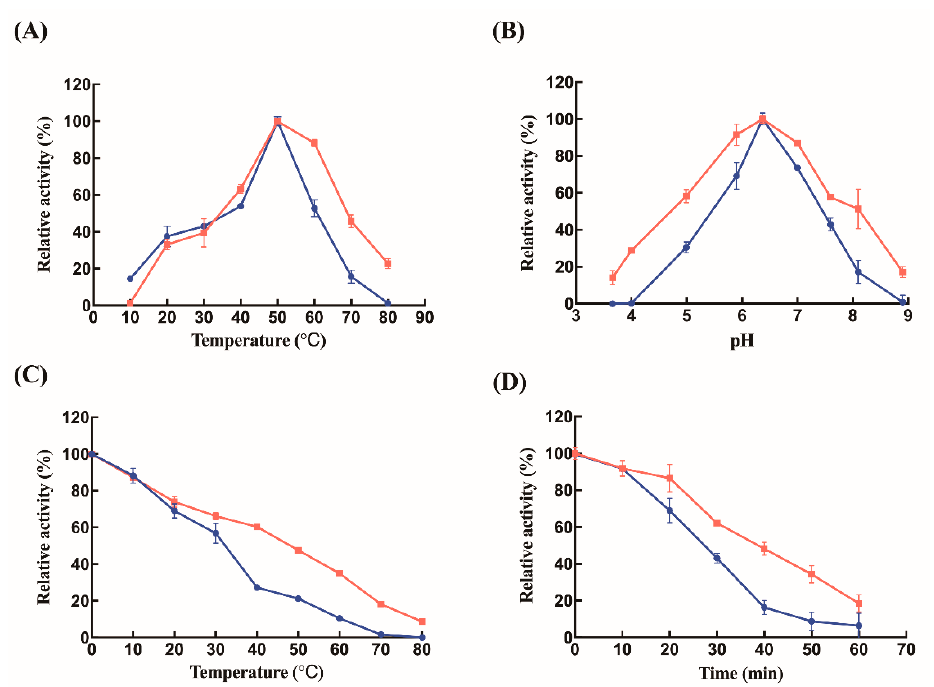
Figure 3. Biochemical characterization of free (blue circles) and immobilized (red squares) lysozyme. ( A ) Optimal temperature of the free lysozyme and immobilized lysozyme. The activities were determined in 20 mM sodium phosphate buffer (pH 6.5) for different temperatures from 10 to 80 °C. ( B ) The effect of pH on the activities of free lysozyme and immobilized lysozyme. Enzymatic activity assay was processed at 50 °C in various buffers as follows: 20 mM sodium acetate buffer (pH 3.7–5.0), 20 mM phosphate buffer (pH 6.0–7.0), and 20 mM glycine-NaOH buffer (pH 7.6–8.9). ( C ) Thermal stability of free lysozyme and immobilized lysozyme. Enzyme was incubated at various temperatures without substrate for 30 min and then its residual activities assayed at 50 °C and pH 6.5. ( D ) Thermo-stability of free and immobilized lysozyme at 37 °C for incubation at different times. The enzymatic activity of a fresh sample of free or immobilized lysozyme measured in 20 mM sodium phosphate buffer and at 50 °C was defined as 100%.